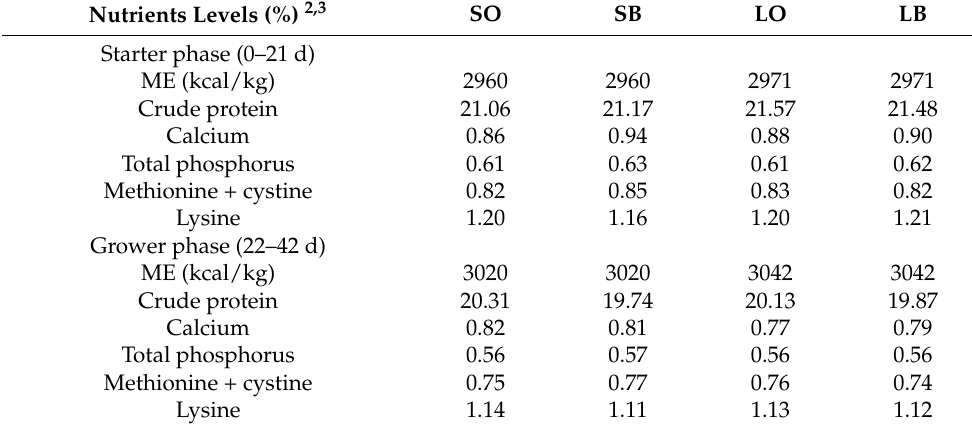
Table 2. Analyzed levels of nutrients of diets (%) 1